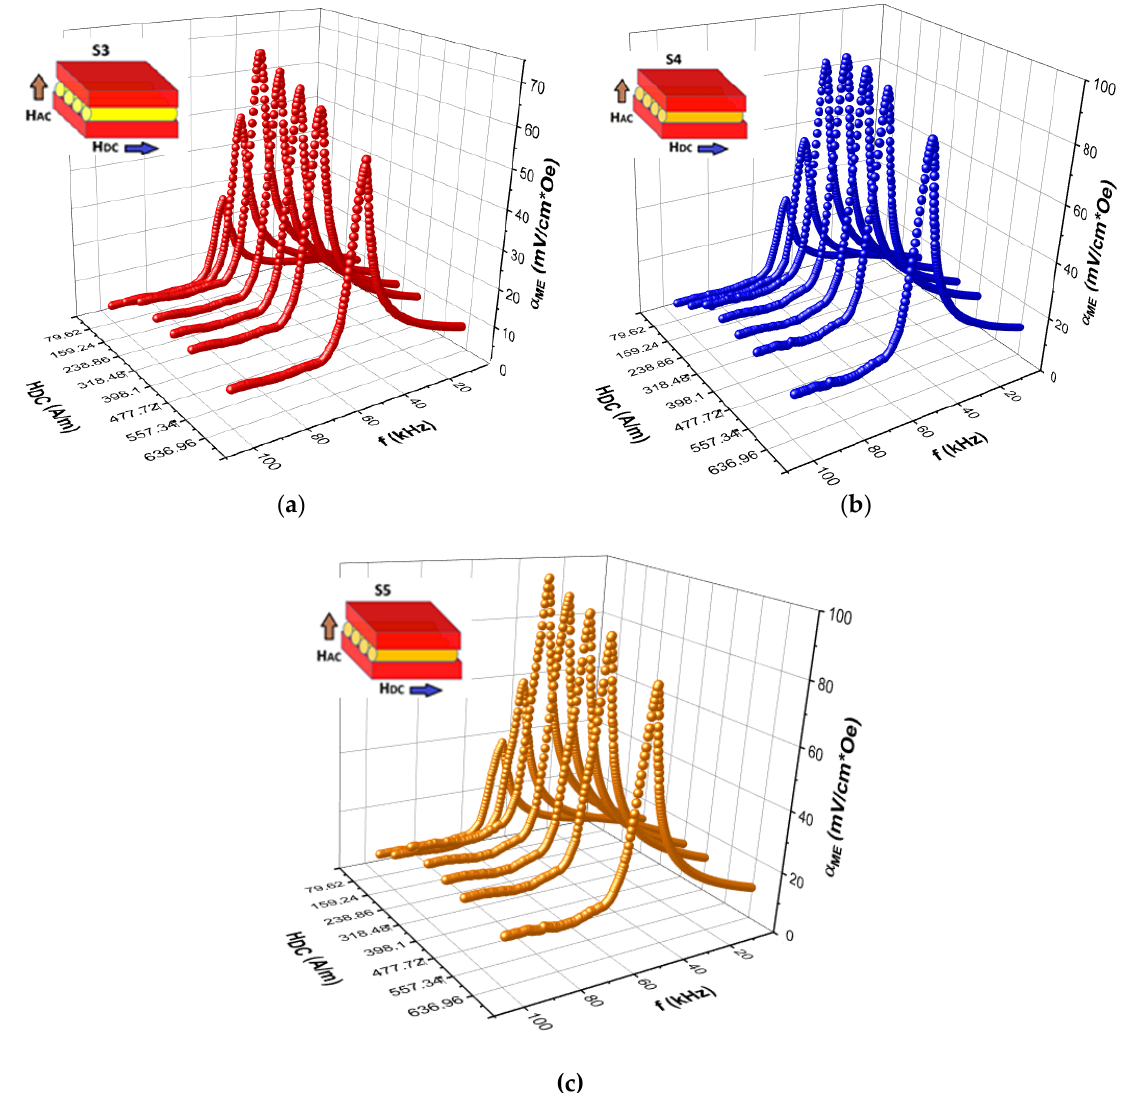
Figure 7. Frequency dependencies of the ME voltage coe ffi cient for di ff erent DC bias field H DC for sandwiches with microwires after glass removal (S3 ( a ), S4 ( b ), S5 ( c ); S4, and S5 were also annealed before and after glass removal, respectively).